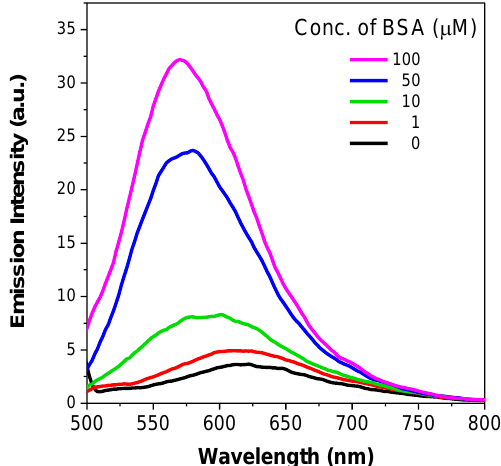
Figure 12. Fluorescence emission spectra of dye 3 with various concentrations of BSA in phosphate-buffered saline (PBS) excited at 420 nm.